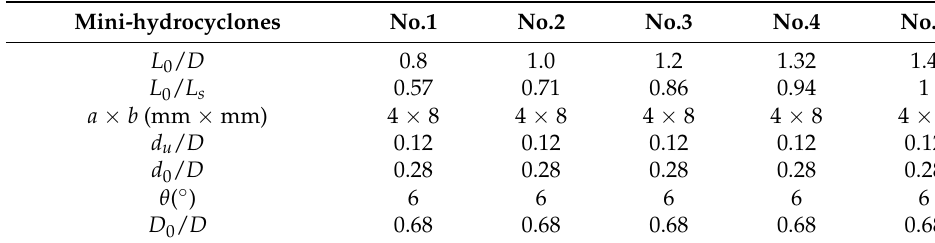
Table 1. Mini-hydrocyclones structure parameters in the fluent simulation.